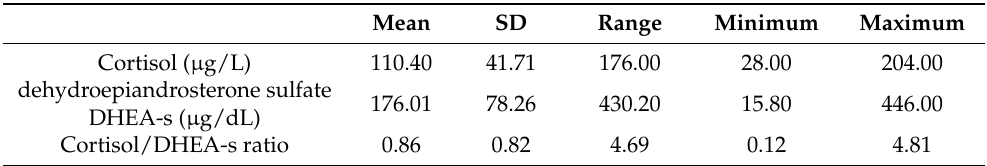
Table 2. Circulating levels of hormones for the